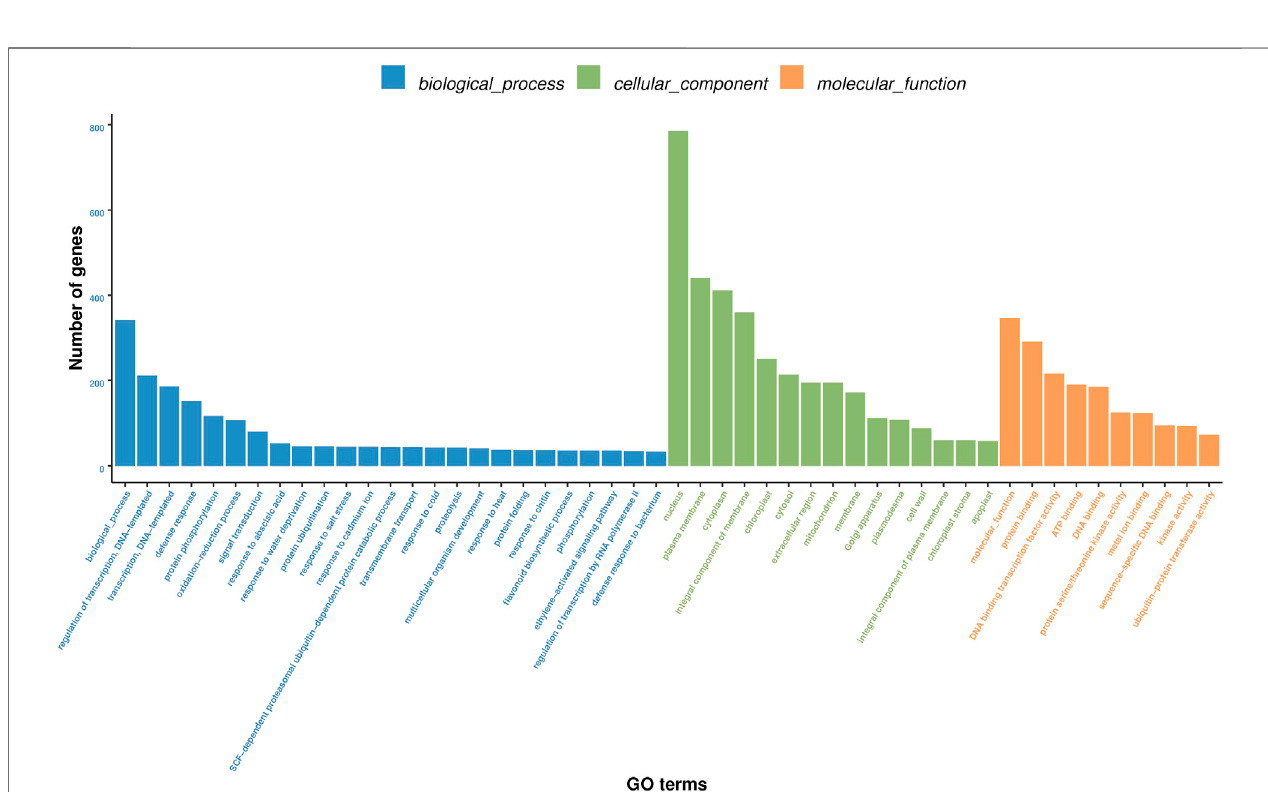
FIGURE 6 | Analysis of D_R vs S_R differentially expressed gene GO enrichment.